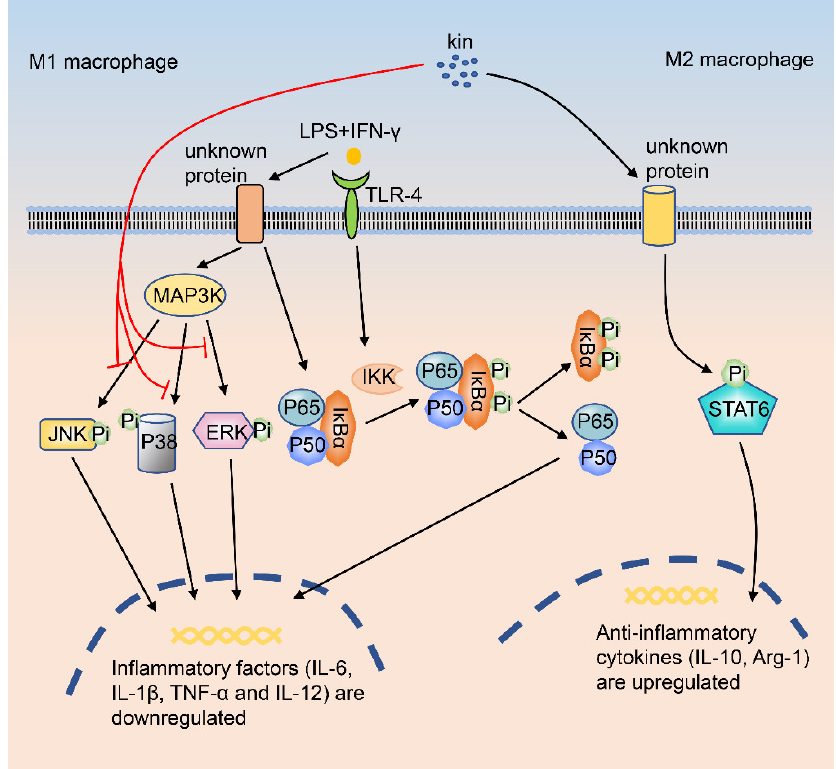
Figure 2. Kin regulates macrophage polarization through MAPK, NF-κB, and STAT6 signaling